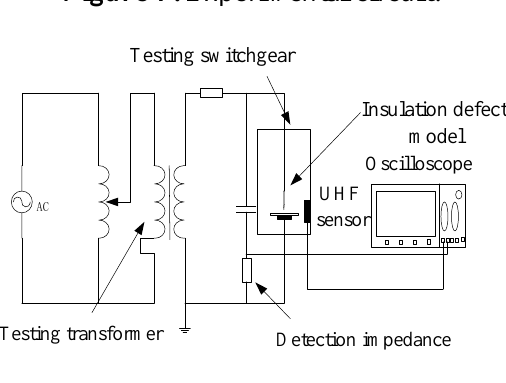
Figure 7. Experimental circuit.